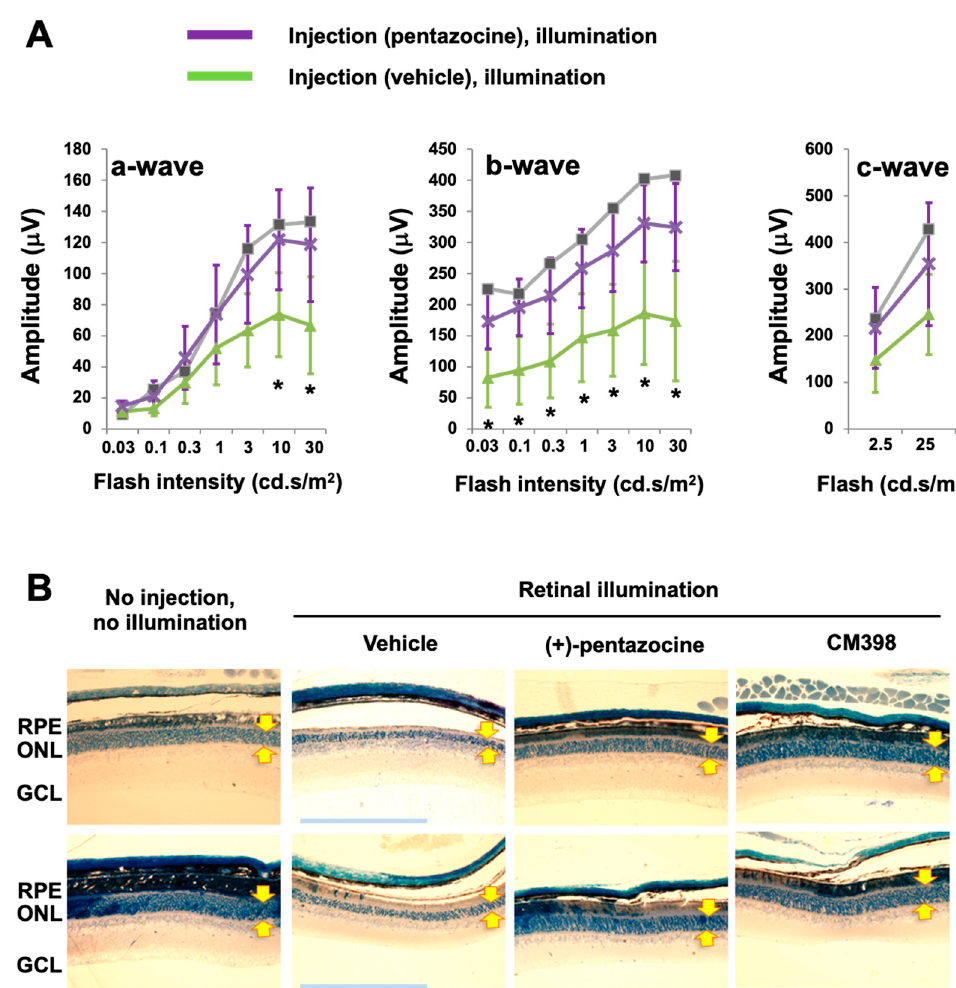
Figure 1. Pretreatment with (+)-pentazocine protects photoreceptor function in Abca4 − / − Rdh8 − / − mice. Mice received a one-time i.p. injection of 1 mg/kg (+)-pentazocine 30 min before retinal illumination (10,000 lux for 30 min). The mice were subjected to ERG recording 7 days after housing in the dark ( A ), and then euthanized for retinal histology ( B ). ( A ) ERGs. Student’s t -test was performed to compare the (+)-pentazocine-treated group and the vehicle control group at each scotopic light intensity, mean ± SD, n = 4 mice in each group, * p < 0.05. The gray curve measured with one mouse represents the basal condition (no injection, no illumination). ( B ) Methylene blue-stained retinal sections. Images shown are representative sections from two animals for each treatment group. The imaged region is within 1000–2000 μ m from the optic nerve head. Arrows demarcate ONL thickness. RPE: retinal pigment epithelium. ONL: outer nuclear layer. GCL: ganglion cell layer. Scale bar: 200 μ m.